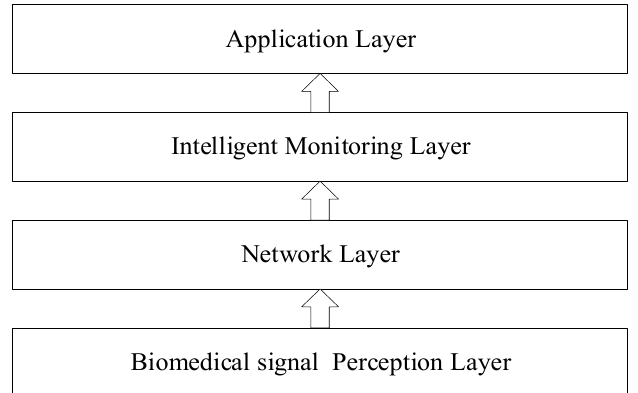
Figure 1. Intelligent biomedical signal monitoring